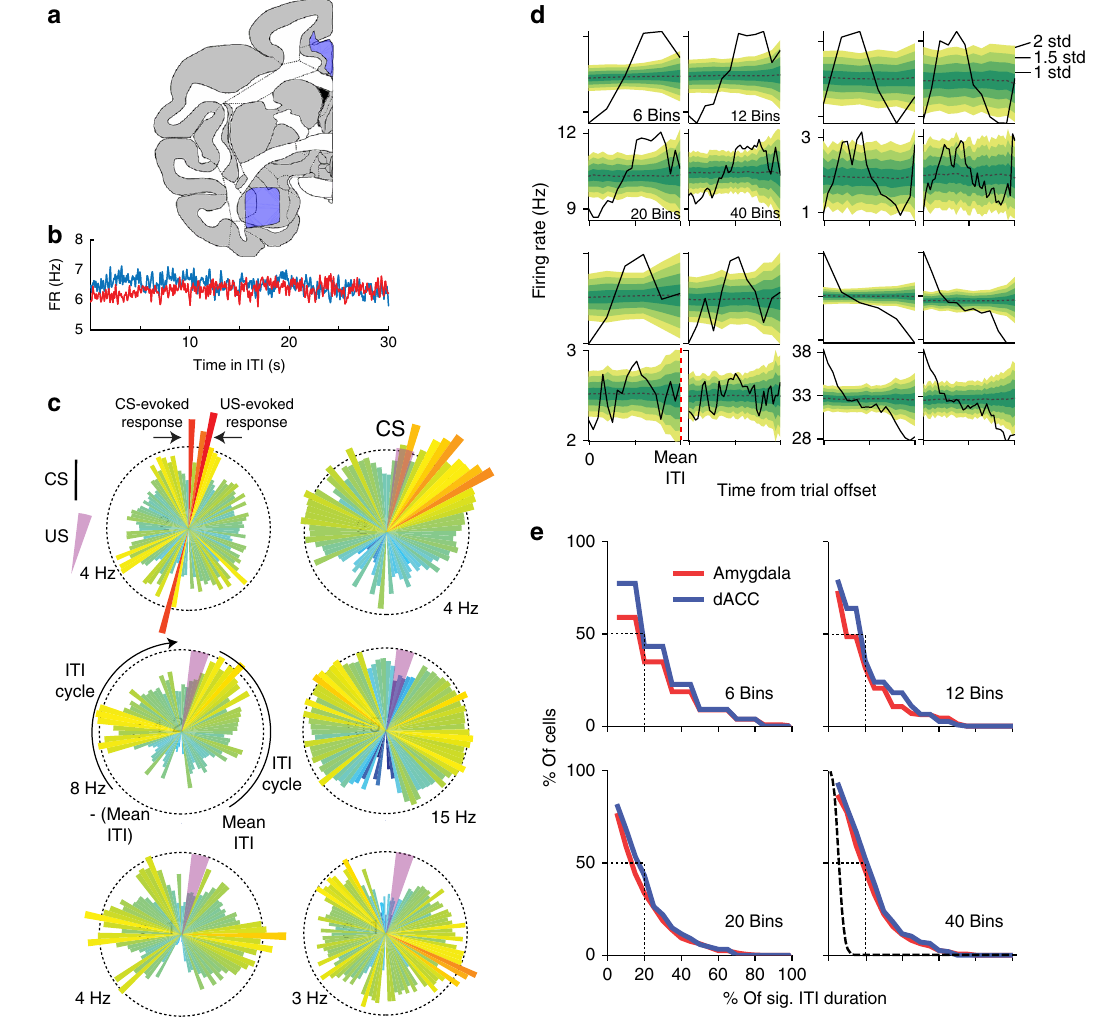
Fig. 3 Neurons in the amygdala and the dACC are modulated during the ITI. a Recording locations were all made within the purple surfaces, shown on top of a macaque atlas (at AC = 0, IA = + 20 mm, adapted from ref. 70 and http://www.braininfo.org. b Firing rate (FR) during 30 s aligned to next trial CS, averaged over all sessions (mean ± S.E.M) and neurons in both amygdala and dACC. No period showed speci fi c modulation. c Single-cell fi ring rates of three amygdala neurons (left column) and three dACC neurons (right column). Modulation occurs not only in response to the CS and the US (as in the left top example) but also during different periods in the ITI. Shown are PSTHs for two ITI cycles, before and after the CS-US (CS is marked by black vertical line upwards, US by light purple wedge, and mean ITI in the session is marked in dashed red lines). The ITI that comes before the CS is on the left half- circle, and the ITI that comes after the US is on the right half-circle. The instantaneous fi ring rate is represented by the vector size and the colormap. d ITI- FR modulation evaluated from trial offset (time 0) to the mean ITI (dashed red line). Shown are four single-cell examples of the actual ITI-FR (black line) binned into 6, 12, 20, or 40 bins (for robustness) and the shuf fl ed con fi dence interval (yellow-green shades). Notice that data were shuf fl ed only between bins that occur before a new trial initiates, and as a result the con fi dence interval increases toward the end of the ITI. e Histograms of the proportion of cells ( y -axis) that showed signi fi cant ITI-FR modulation (ITI-FR > 2 s.t.d. of the shuf fl ed FR) in a proportion of the ITI duration ( x -axis). For example, 50% of the cells had signi fi cant modulation in 20% or more of the ITI duration (dashed black line). All binning options are shown for robustness. A null distribution (obtained from shuf fl ing) is shown for comparison in dashed black line, where most cells had signi fi cant modulation at around 5% of the time (as expected from chance). Single units: amygdala: n = 291; dACC: n =